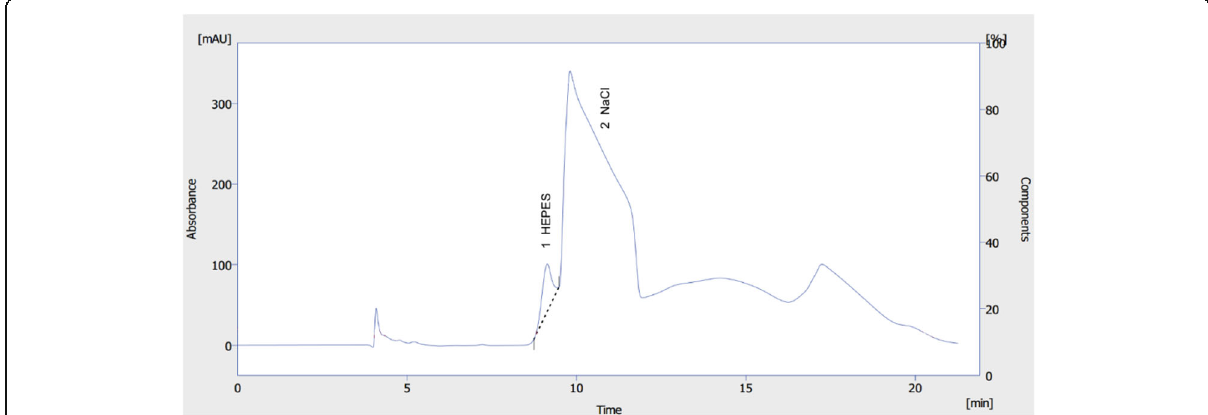
Fig. 3 Representative HPLC chromatogram of HEPES (1 mg/mL) obtained by the method according to Kvaternik et al.